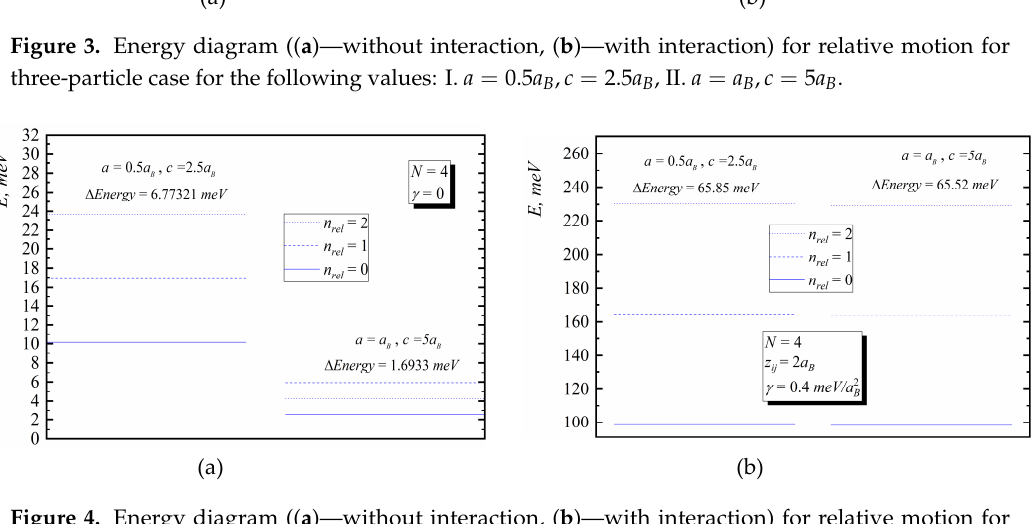
Figure 5. Energy diagram for the center of mass motion for the following values: I.